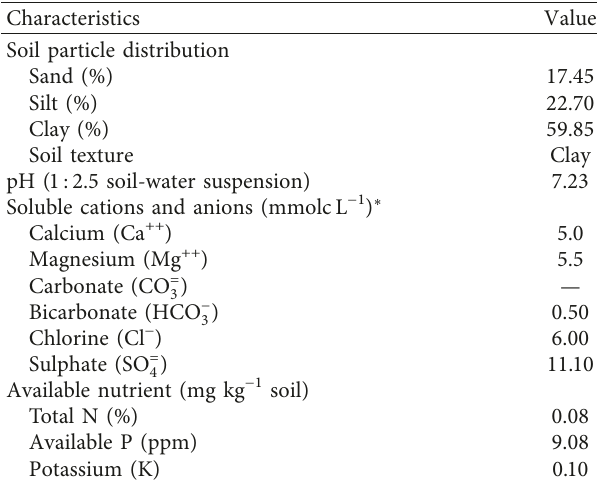
Table 1: Physical and chemical properties of soil at the experi- mental site.